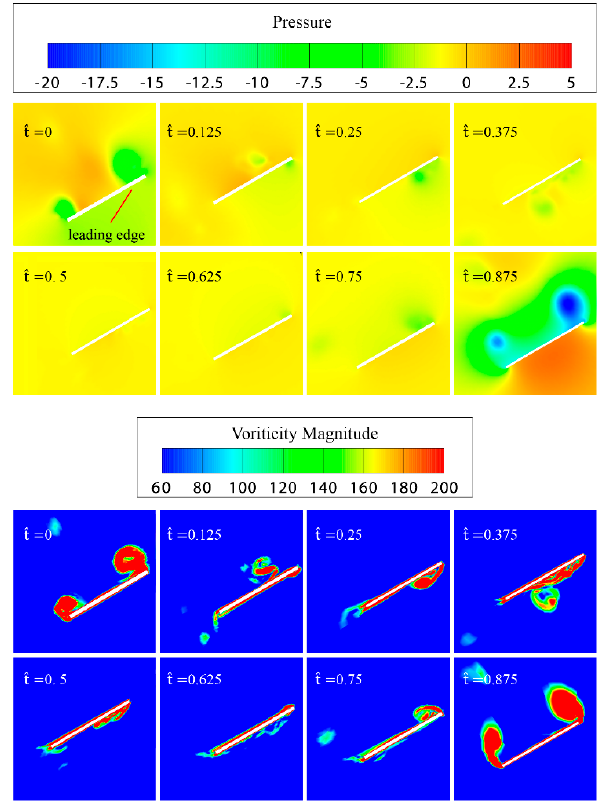
Figure 16. Variation of the pressure and vorticity in a flapping cycle in case 4.